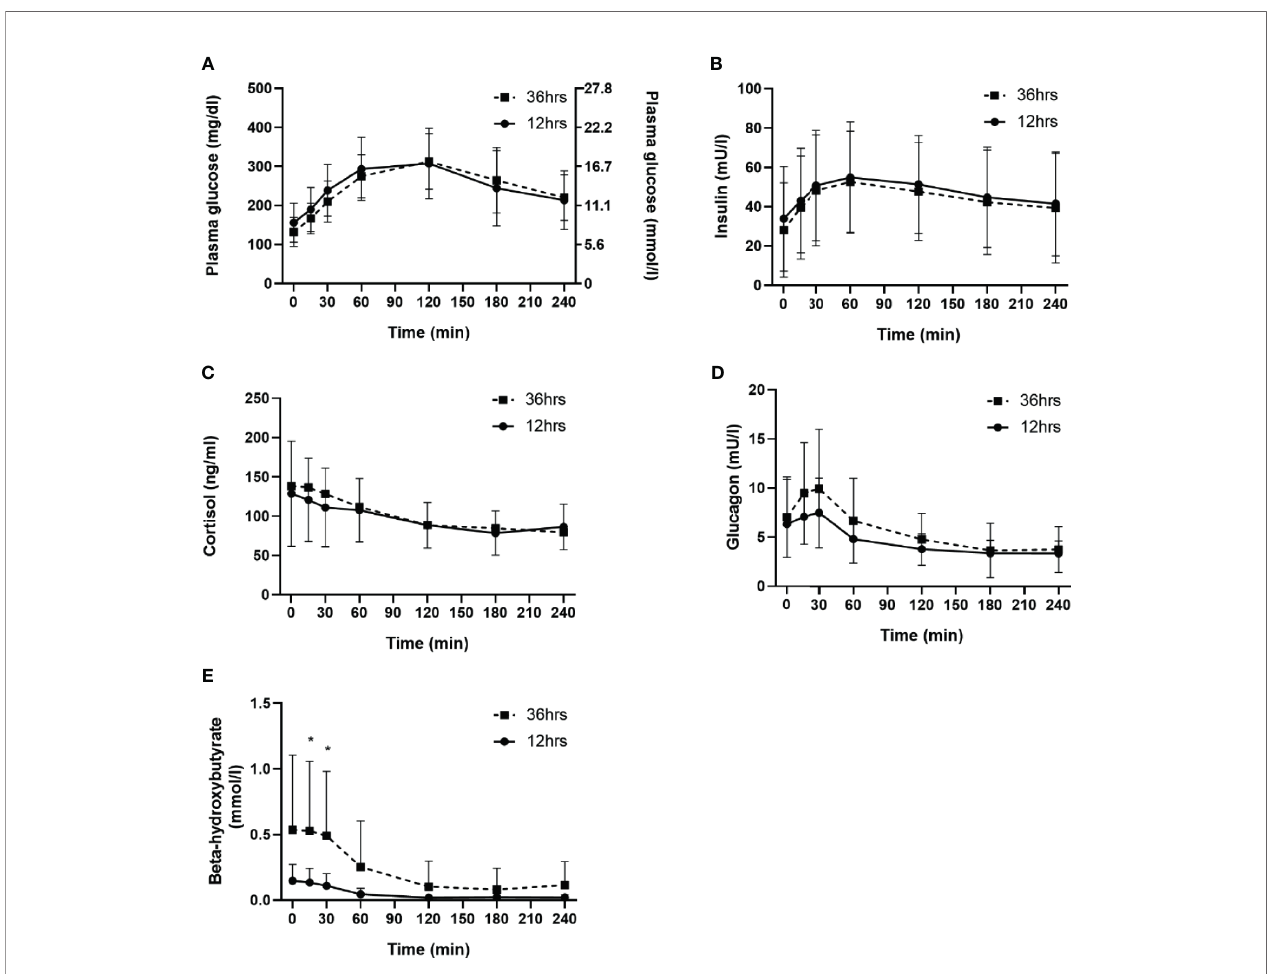
FIGURE 2 | Comparison of 12 hrs fasting vs. 36 hrs fasting for plasma glucose (A) , insulin (B) , cortisol (C) , glucagon (D) and beta-hydroxybutyrate (E) . * indicates signi fi cant difference for the speci fi c time point n comparison of both trial arms (n =